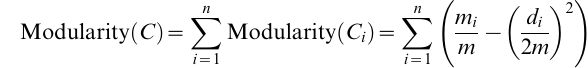
distribution (blue bars) of the number of validated lipid associating genes by randomly select 1000 sets of 395 genes, and the statistic calculated based on the 395 cis-eSNP genes belonging to the conserved modules (red line). (C) Null distribution (blue bars) of the number of ApoE first neighbor genes among 1000 randomly selected sets of 500 genes, and the statistic calculated based on the 500 differentially connected genes (red line). Figure S6 Module enrichment of lipid-associating genes at different windows sizes. The interpretation of the figures is the same as that of main text Figure 4. Figure S7 Conserved and differential interactions between human and rodent species. (A) Human vs. mouse comparison. (B) Human vs. rat comparison. Numbers in the parenthesis are number of genes in each category. P-values were computed using Kruskal Wallis non-parametric test of equal medians (median Ka/ Ks for the ‘‘Conserved Only’’ and ‘‘greater or euqal to 1 Different’’ categories are respectively 0.090 and 0.103 for the human vs. mouse comparison; and 0.086 and 0.101 for the human vs. rat comparison). Figure S8 In comparison with genes involved in only conserved interactions between human and rodents (box on the left), genes having human-specific interactions with human-rodent orthologs (box on the right) display a higher ratio of interactions to human- specific genes vs. human-rodent orthologs in the human liver co- expression network. Top 161 genes from each group were used for plotting the two boxes. Human liver co-expression network was built as previously reported. For genes in each group, its ratio between the numbers of interactions to human-specific vs. human- rodent orthologs is plotted on the Y-axis. Table S1 Summary of the pros and cons of existing meta- analysis methods Table S2 6455 orthologous genes among human, mouse and rat used in the analysis. Table S3 Ordered annotations of human liver samples shown in Figure S3A. TXT) Table S4 Ordered human gene symbols for genes shown in Figure S3A. TXT) Table S5 Ordered annotations of F2 mouse liver samples shown in Figure S3B. TXT) Table S6 Ordered mouse gene symboles for genes shown in Figure S3B. TXT) Table S7 Ordered annotations of rat liver samples shown in Figure